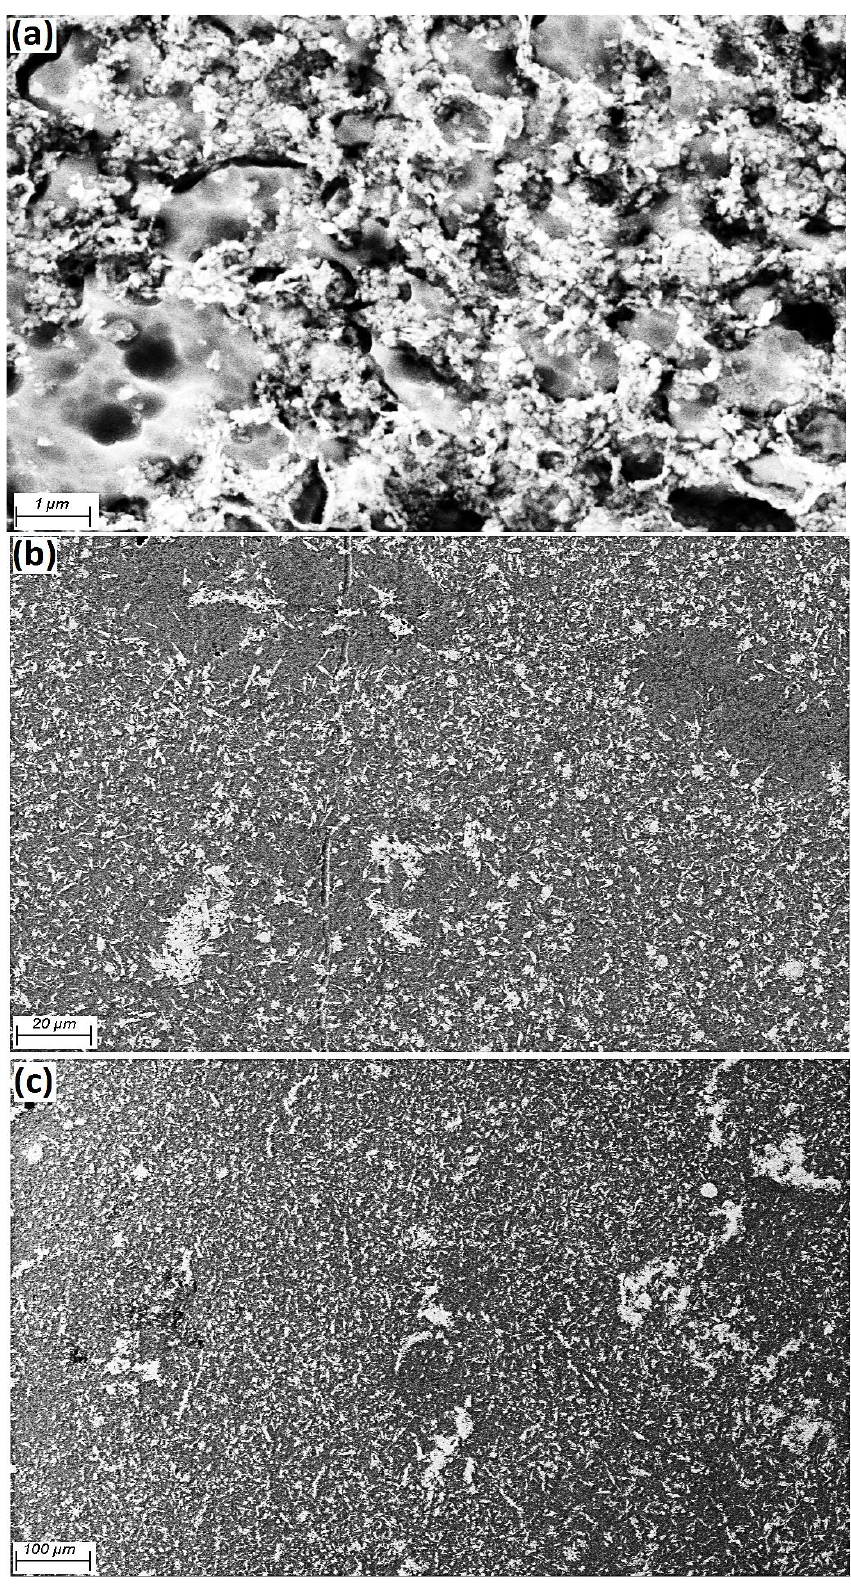
Figure 4. FESEM of a.5 composite, ( a ) 1 µm, ( b ) 20 µm, ( c ) 100 µm.